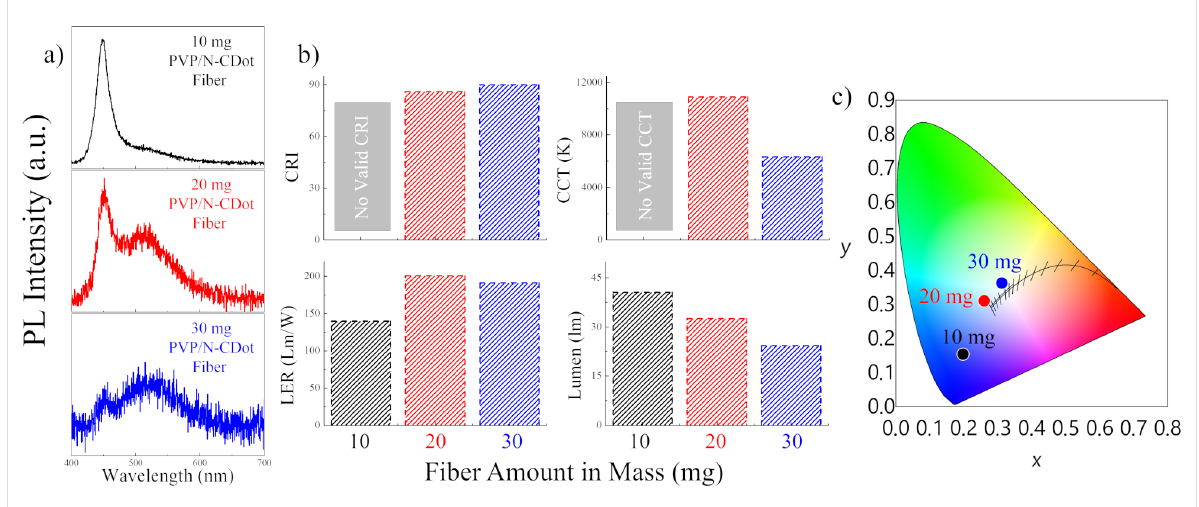
Figure 5: (a) PL spectra of the white light generated by employing color conversion layers with different amounts of PVP/N-CDot fibers coupled to a 450 nm blue LED chip. (b) The calculated CRI, CCT, LER and luminous flux values of the corresponding PVP/N-CDot fibers. (c) The CIE color coordi- nates of the white light generated by the WLED comprising varying amounts of the PVP/N-CDot